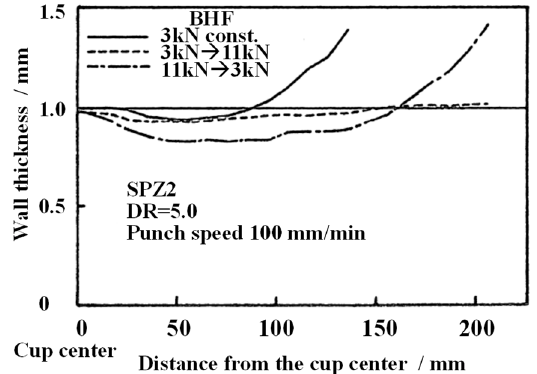
Figure 7. Comparison of thickness distribution of a drawn cup at a punch stroke of 60 mm under different BHF patterns (DR = 5.0).